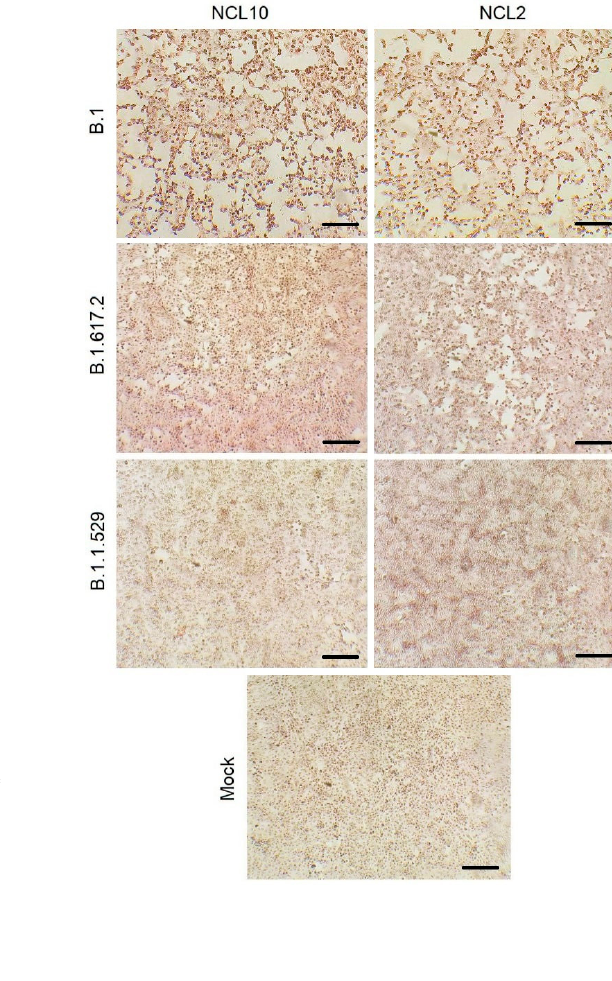
Figure 5. Analysis of specificity of N-specific mAbs in a Vero E6 cell model. ( a ) Dependence of absorbance intensity (OD 450 ) on the concentration ( µ g/mL) of anti-N mAbs or 14C2 mAbs (NC, anti-influenza M2e antibodies). Vero E6 cells were infected with the B.1, B.1.617.2 or B.1.1.529 SARS- CoV-2 variant, followed by cell ELISA with indicated mAbs. ( b ) Immunocytochemical analysis of SARS-CoV-2 N protein in infected Vero E6 cells after 48 h of incubation. The different patterns of cytopathic effects caused by three different strains of SARS ‐ CoV ‐ 2 are visualized. The positive red staining was developed as a result of treatment with the NCL2 and NCL10 (except for the B.1.1.529 detection) mAbs. The mock comprised the untreated cells. Scale bars: 100 μ m.